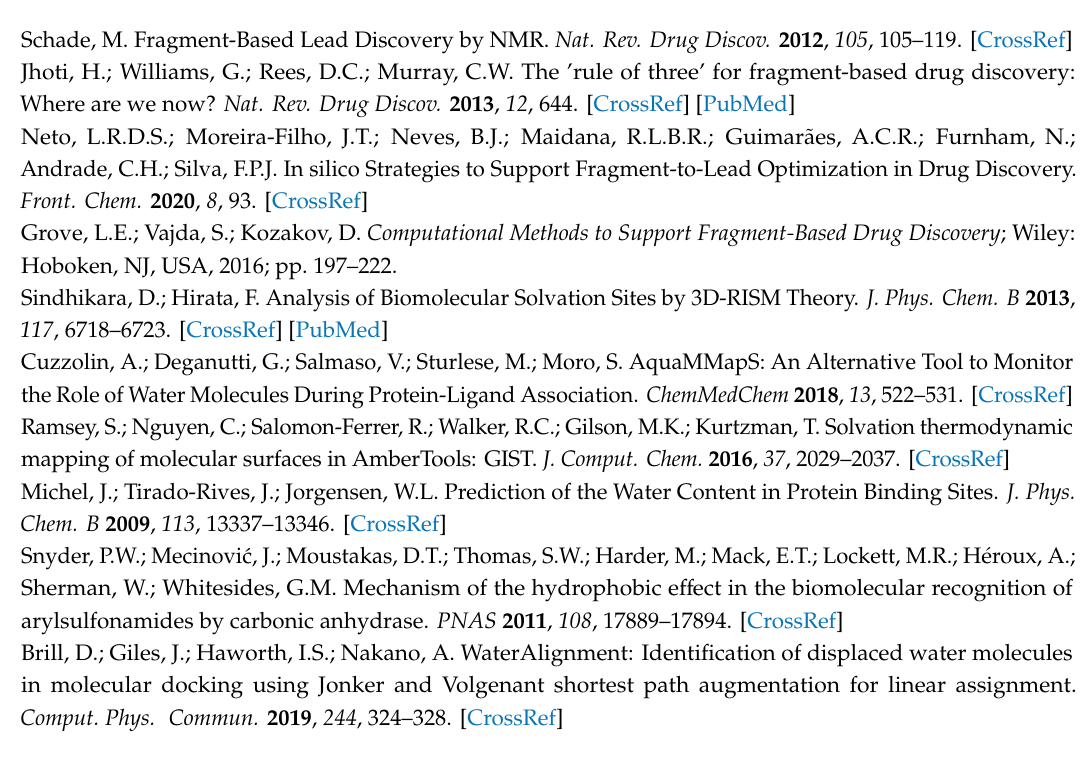
Supplementary Materials: Video S1: SuMD simulation of the binding event of pyrimidinamine. The crystal structure is 2JJC. Video S2: Superposed trajectories of di ff erent SuMD